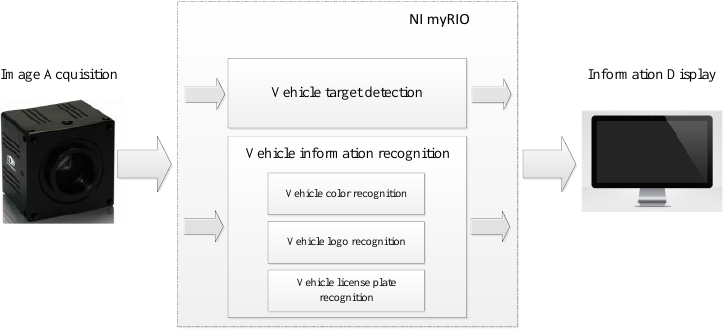
Figure 1. Overall design of vehicle target detection and information extraction system.